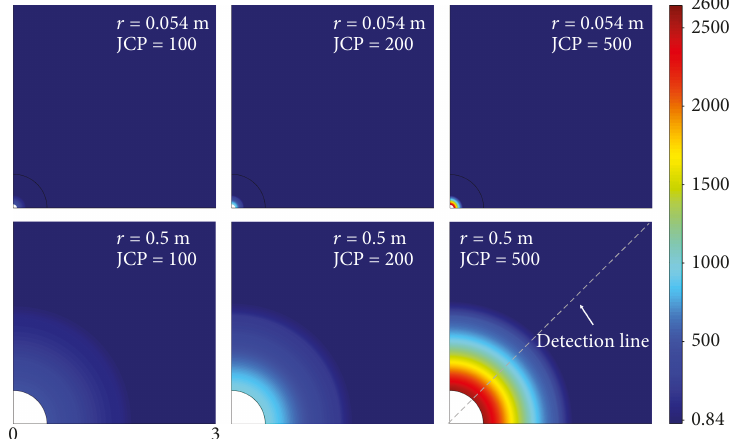
Figure 7: Permeability distribution characteristics around a